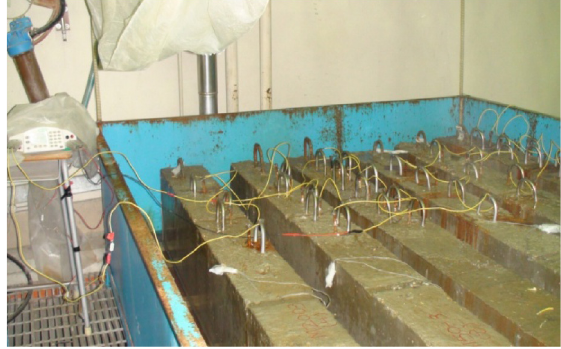
Fig. 4. Accelerated corrosion setup